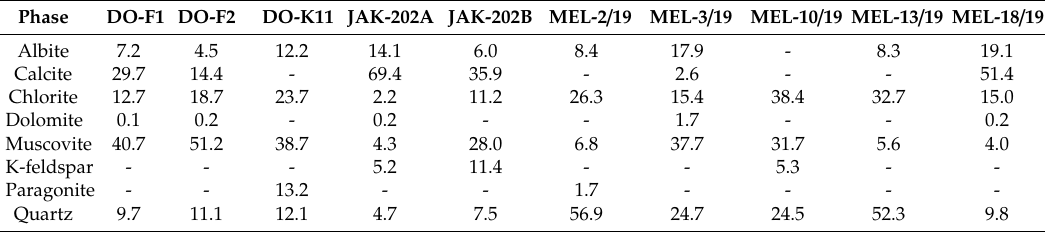
Figure 25. Powder XRD patterns of the Meliata Unit flysch metasediments. The peaks indicate mineral phases in the fine-grained rock matrix. Table 8. Quantitative proportion of mineral phases calculated from the powder X-ray di ff raction (PXRD) data by Rietveld quantitative